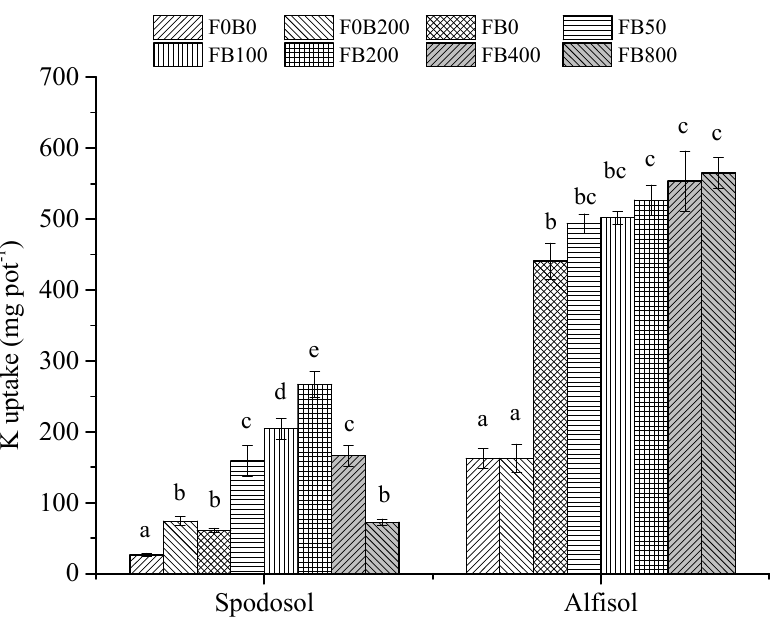
Figure 5. K uptake of maize plants affected by different application rates of CNPs in Spodosol and Alfisol soils. F0B0, control (without fertilizers and CNPs); F0B200, without fertilizers and with CNPs at 200 mg kg − 1 soil; and FB0, FB50, FB100, FB200, FB400 and FB800 represent those with fertilizers and CNPs at application rates of 0, 50, 100, 200, 400 and 800 mg kg − 1 soil, respectively. Error bars represent the standard error of the mean ( n = 5). The letters a, b, c, d and e indicate statistically significant difference at p < 0.05 within each group comparison between the treatments. Bars with no common letters are significantly different ( p < 0.05). Due to ammonium toxicity, the treatments of FB0 and FB800 in Spodosol soil resulted in significantly lower nutrient use efficiency ( p < 0.05). However, the CNPs amendment to the sandy soils significantly improved fertilizer use efficiency by corn plants ( p < 0.05; Table 1). For instance, the treatment of CNPs at 200 mg kg − 1 in Spodosol led to the highest N, P and K use efficiency—increases of 48.8%, 11.8% and 26.7%, respectively. As for Alfisol soil, the highest use efficiency of N, P and K by corn plants occurred in FB200, FB800 and FB800, respectively—increases of 39.6%, 34.3% and 44.6%, respectively. Table 1. Nutrient use efficiency of corn plants affected by different application rates of CNPs in Spodosol and Alfisol soils. N Use Efficiency (%) P Use Efficiency (%) K Use Efficiency Items